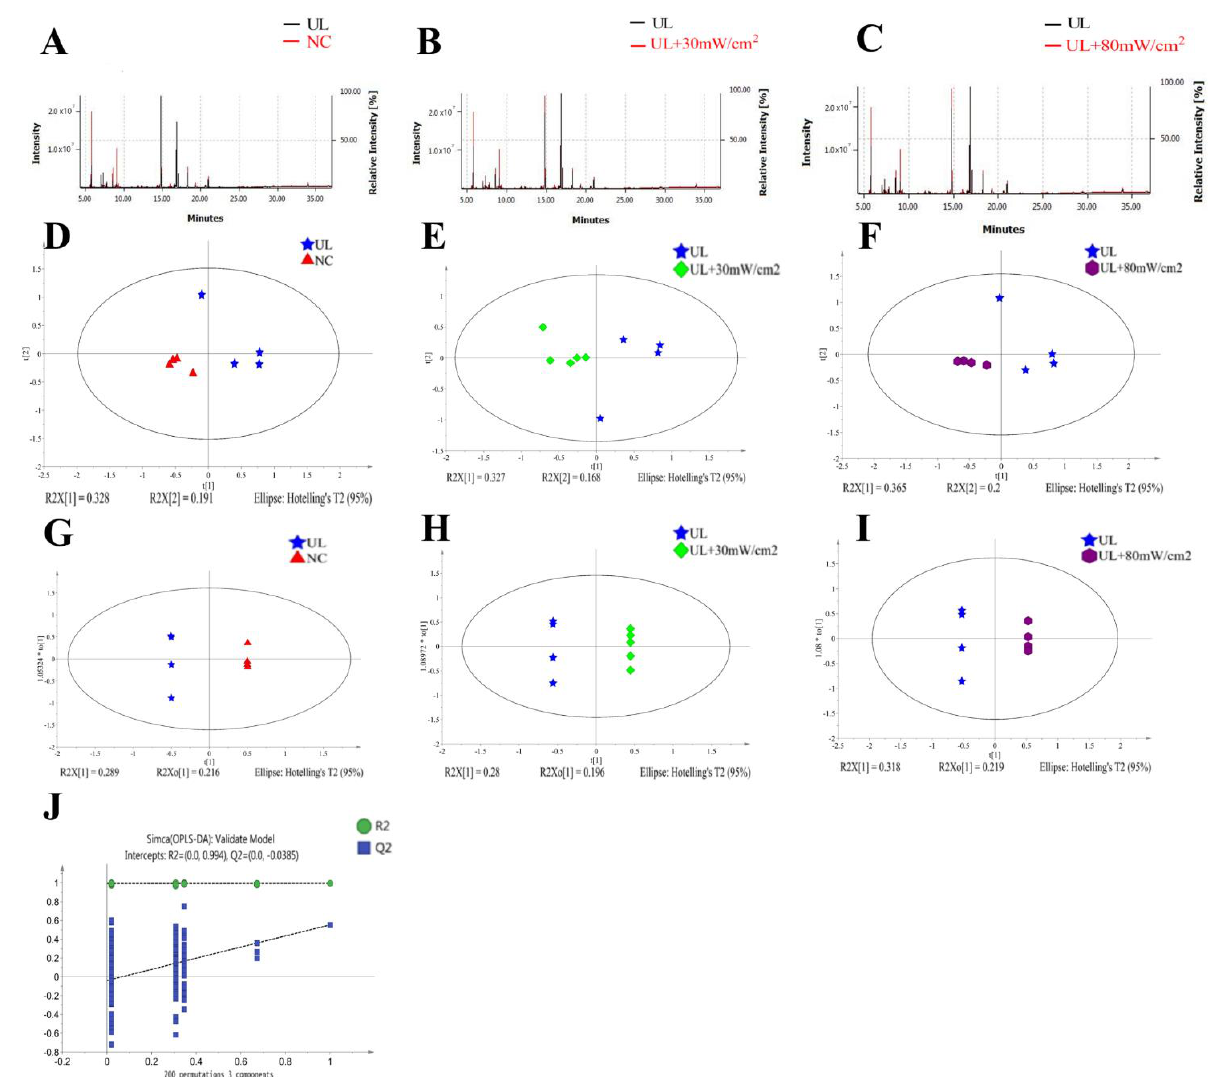
Figure 7. ( A ) Blood total ion flow diagram of NC and UL groups. ( B ) Blood total ion of UL and 30 mW/cm 2 LIPUS groups. ( C ) Blood total ion flow diagram of UL and 80 mW/cm 2 LIPUS groups. ( D ) PCA score of UL and NC group. ( E ) PCA score of UL and 30 mW/cm 2 LIPUS groups. ( F ) PCA score of UL and 80 mW/cm 2 LIPUS groups. ( G ) The OPLS-DA score of UL and NC rats. ( H ) The OPLS-DA score chart of UL and 30 mW/cm 2 LIPUS groups. ( I ) The OPLS-DA score of UL and 80 mW/cm 2 LIPUS groups was compared. ( J ) Validation of OPLS-DA model of rats blood samples from four groups by permutation test (the x-axis means the correlation coefficient between the original y variable and the permutated y variable and the y-axis is the value of R2 and Q2).